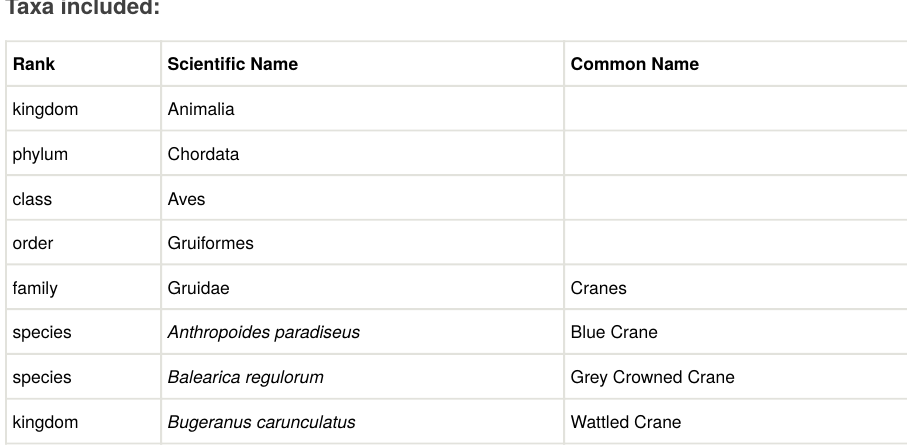
Figure 3. Taxonomic coverage of the dataset includes three crane species n = 26 403 (Family: